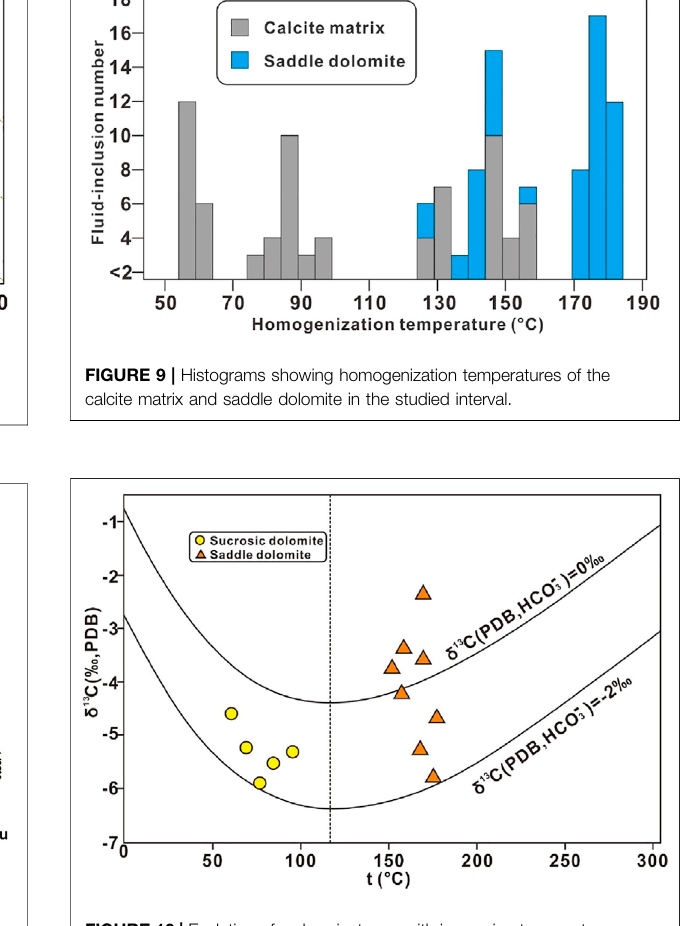
FIGURE 10 | Evolution of carbon isotopes with increasing temperature (Horita, 2014) in the studied interval of the Chihsia